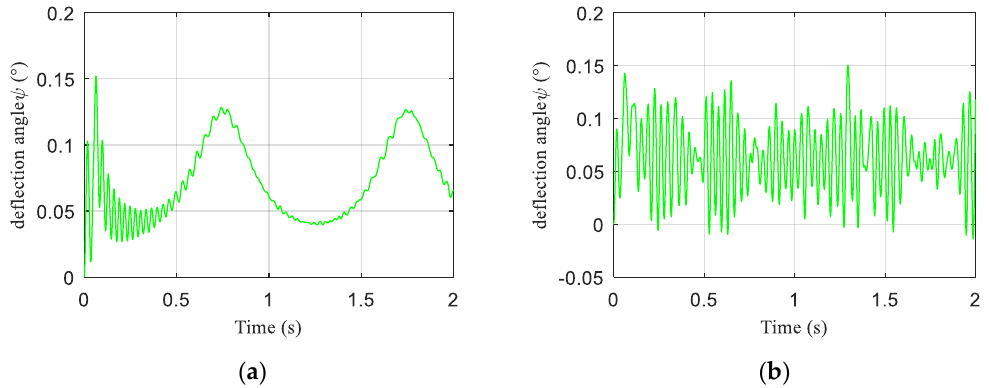
Figure 20. The curve of joint passive deflection angle during stiffness tracking. ( a ) The expected joint stiffness is a sine wave signal. ( b ) The expected joint stiffness is a random signal.